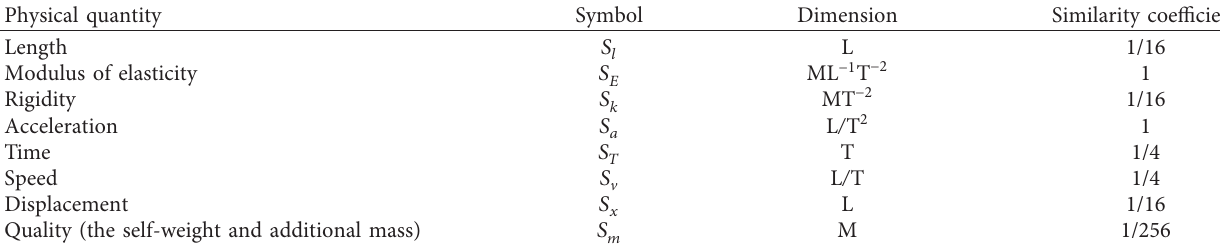
Table 1: Similarity ratios of the test models.